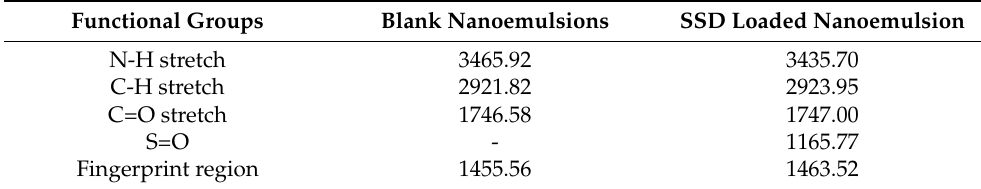
Figure 2. ( a ) FTIR spectra of blank formulation; ( b ) SSD-loaded formulation; ( c ) SSD-loaded nanolotion. Table 3. Interpretation of FT-IR spectra of blank, SSD-loaded nanoemulsion, and